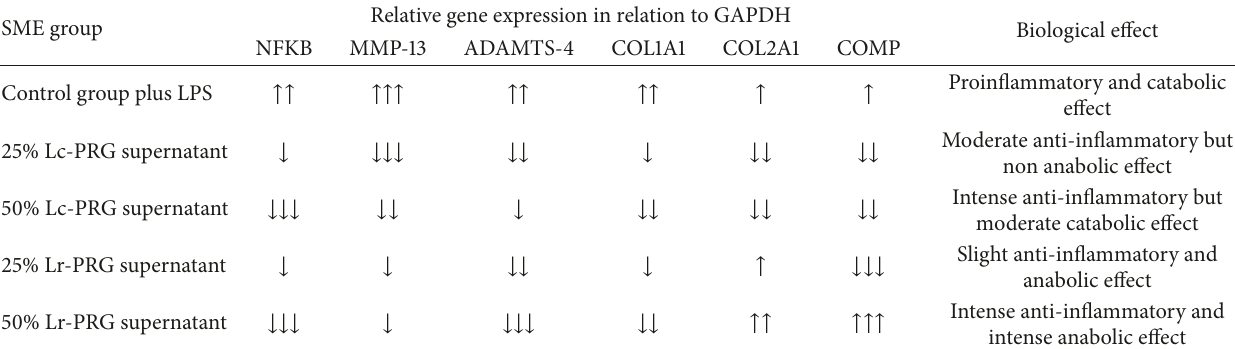
Table 2: General proinflammatory and anabolic gene expression effects of several treatments applied to the synovial membrane explant (SME) groups in this study. ∗